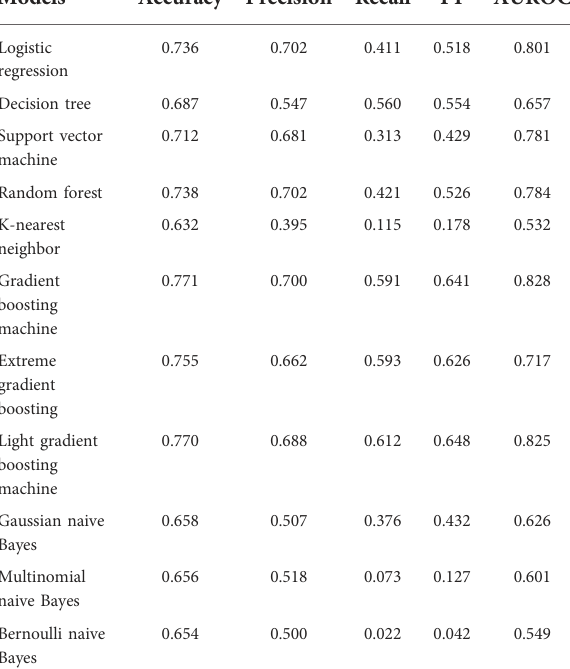
TABLE 2 Prediction performance of 11 machine-learning models for central obesity using accuracy, precision, recall, F1 score, and area under the receiver operating characteristic curve